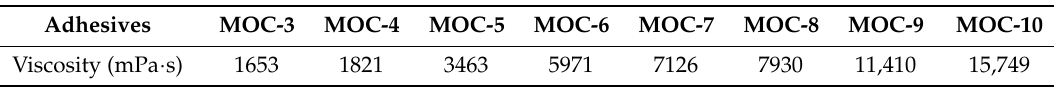
Table 2. The measured viscosity of the different Magnesium oxychloride cement (MOC) adhesives.